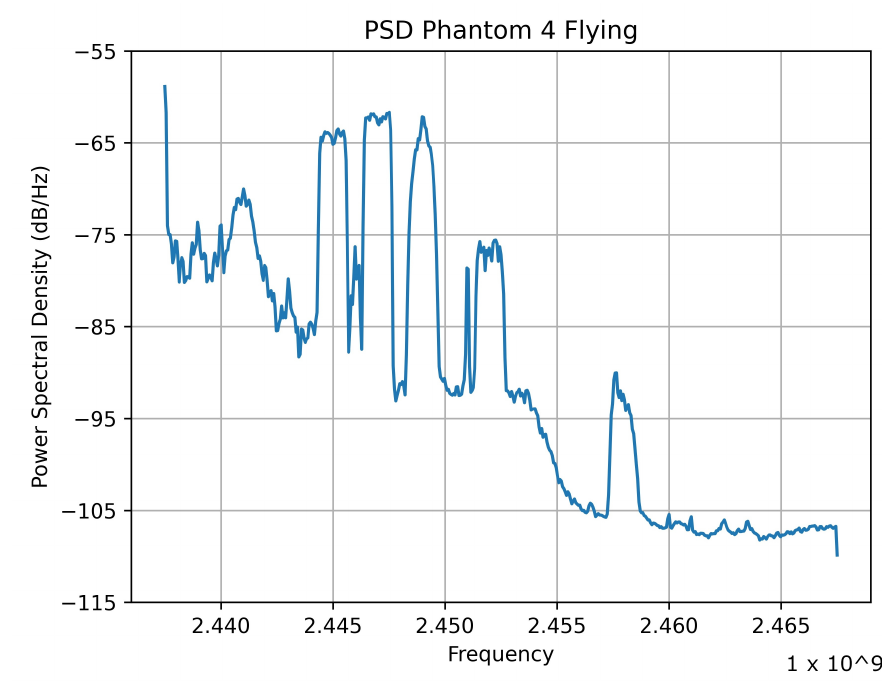
Figure 9. PSD: Phantom 4 flying.